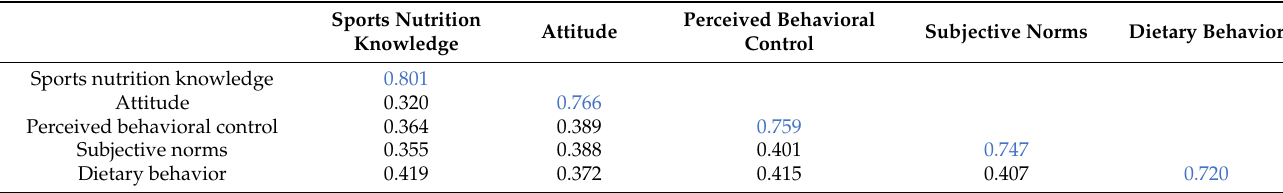
Table 4. Discriminant validity: Pearson correlation and AVE root mean square (RMS) values.